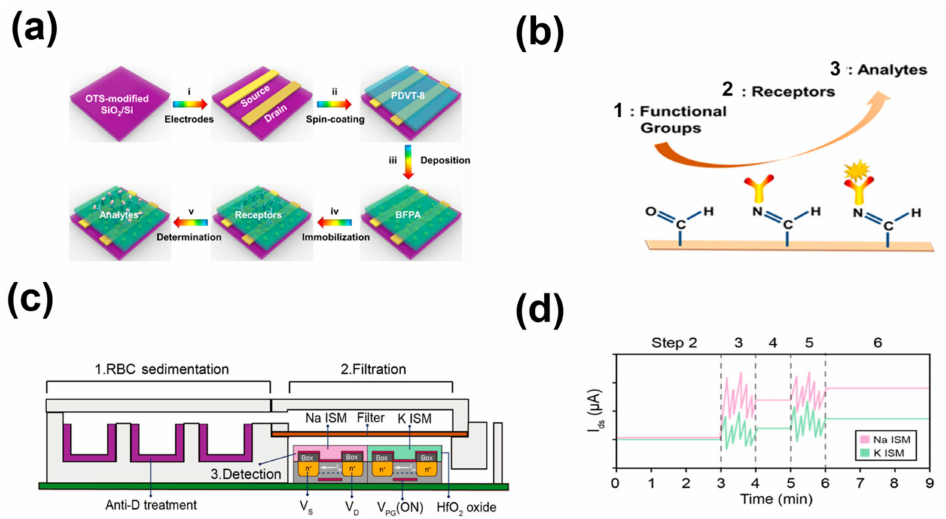
Figure 13. ( a ) Schematic diagram of a bottom-top contact gated organic transistor sensor based on OTFT. ( b ) Organic molecules BFPA and PDVT-8 structure diagram. ( c ) Cutaway view of transistor- ized organic sensor based on OTFT. ( d ) Continuous steps of the I ds profile. ( a ) Reproduced with permission [89]. Copyright 2021, American Chemical Society. ( b ) Reproduced with permission [89]. Copyright 2021, American Chemical Society. ( c ) Reproduced with permission [91]. Copyright 2023, American Chemical Society. ( d ) Reproduced with permission [91]. Copyright 2023, American Chemical